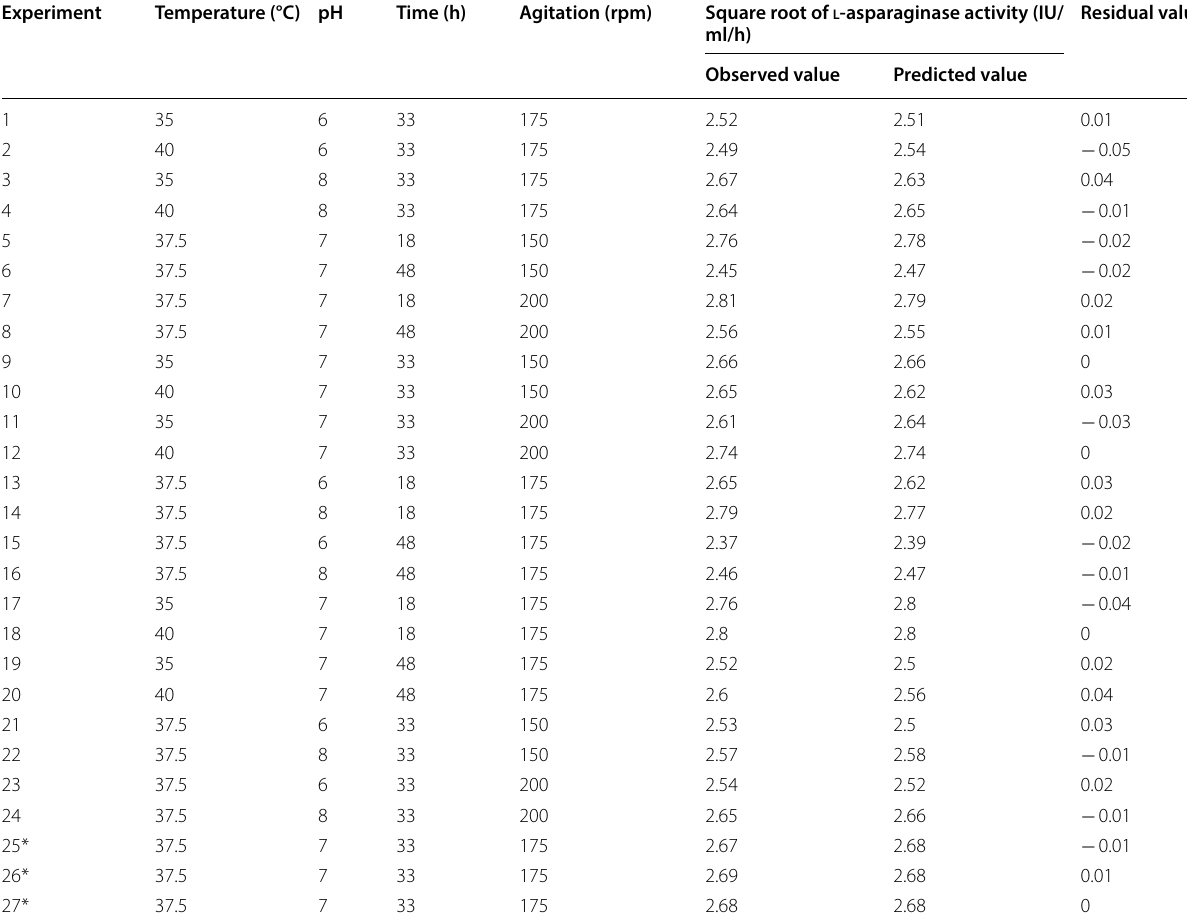
* The 3 replicates at the center point of the tested values (pH, temperature, time, agitation)